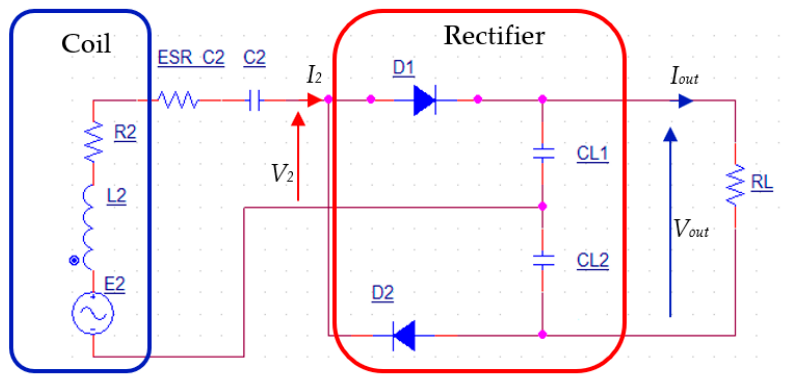
Figure 3. Complete electric schematic of the receiver.